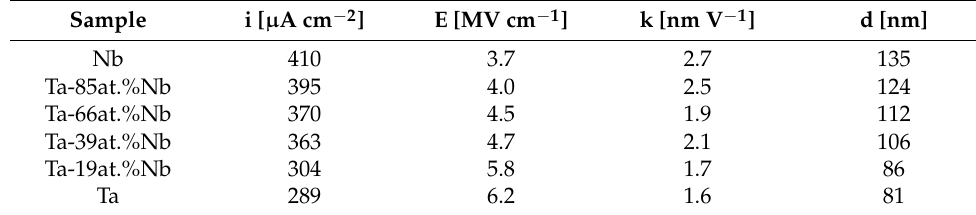
Table 1. Anodic oxides growth parameters, including estimated oxides